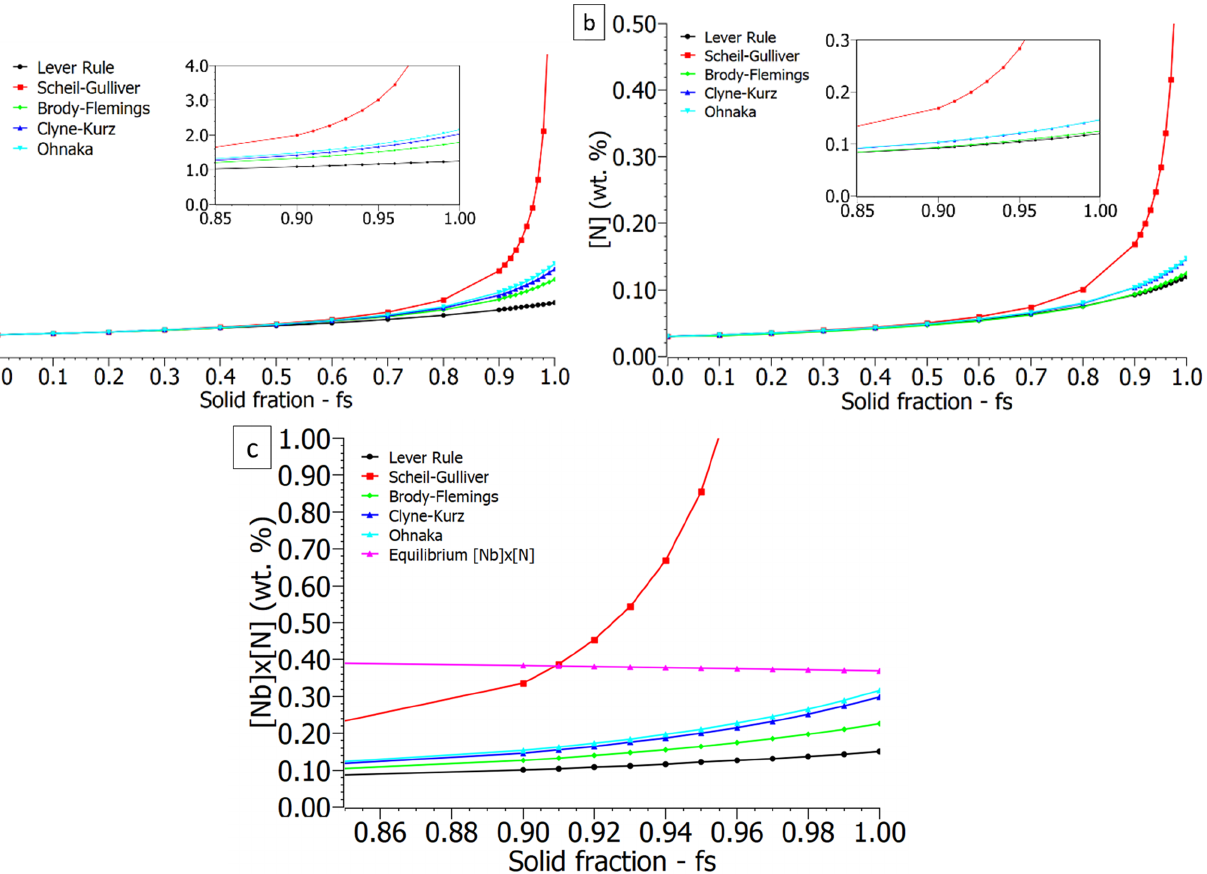
Figure 4. Effect of solid fraction on ( a ) niobium, ( b ) nitrogen, and ( c ) niobium–nitrogen solubility product content under different microsegregation models.